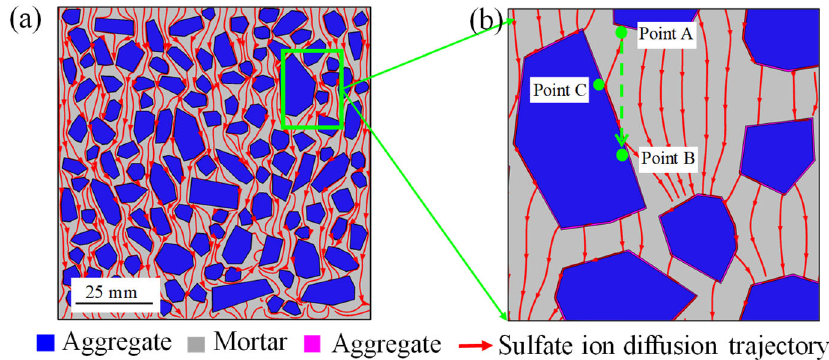
Figure 11. Sulfate ion diffusion trajectories in meso-structures of concrete. ( a ) Overall concrete section, and ( b ) local magnification.